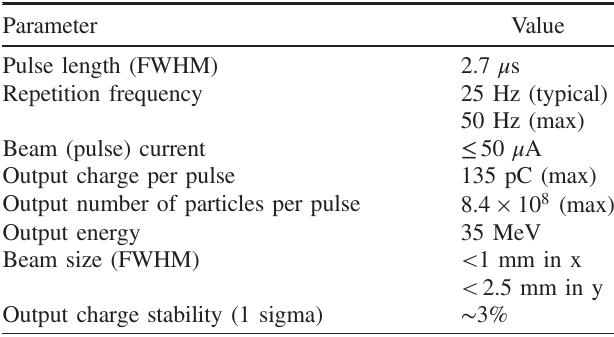
TABLE VI. List of the main parameters of the 35 MeV